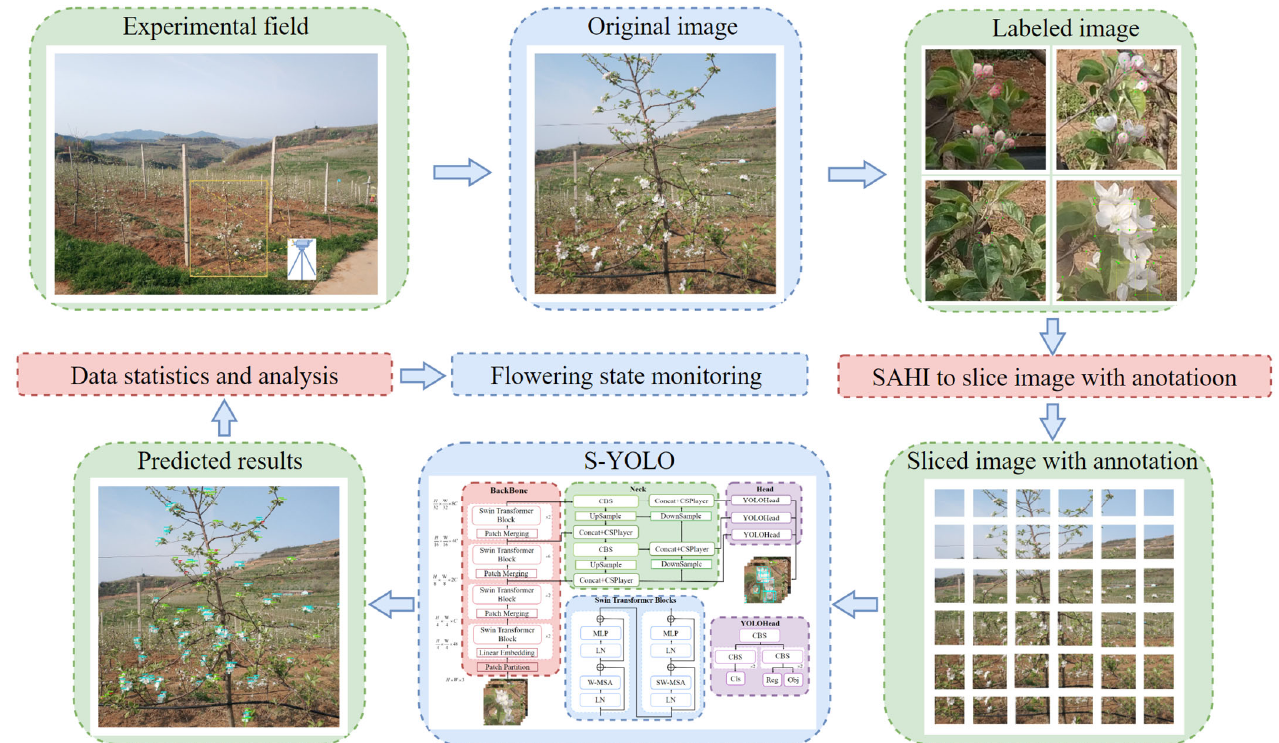
Figure 1. Workflow for monitoring the flowering state of modern standardized apple orchards.